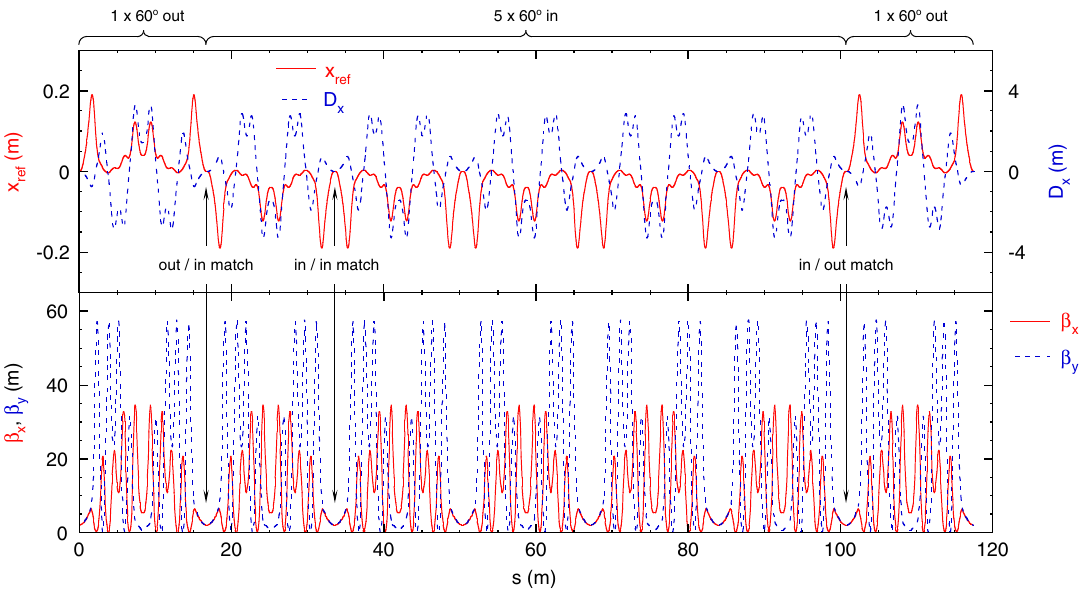
FIG. 5. 1 : 2 GeV =c optics of a complete droplet arc: the horizontal reference orbit x ref and dispersion D x (top) and the horizontal and vertical (cid:1) functions (bottom). The arrows point to the different-type junctions between the outward- and inward-bending